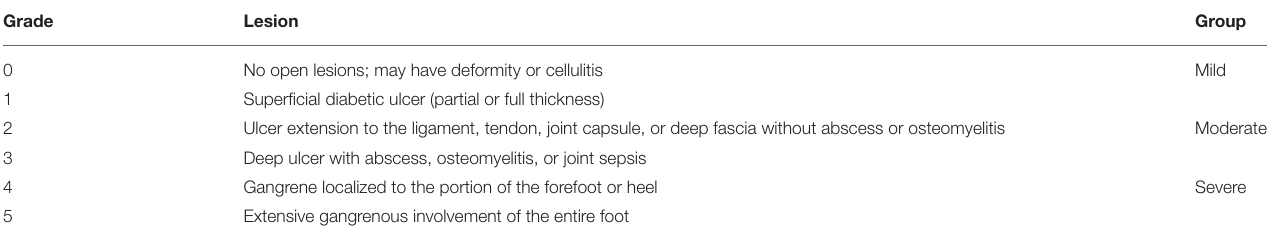
TABLE 1 | Wagner ulcer classification system.